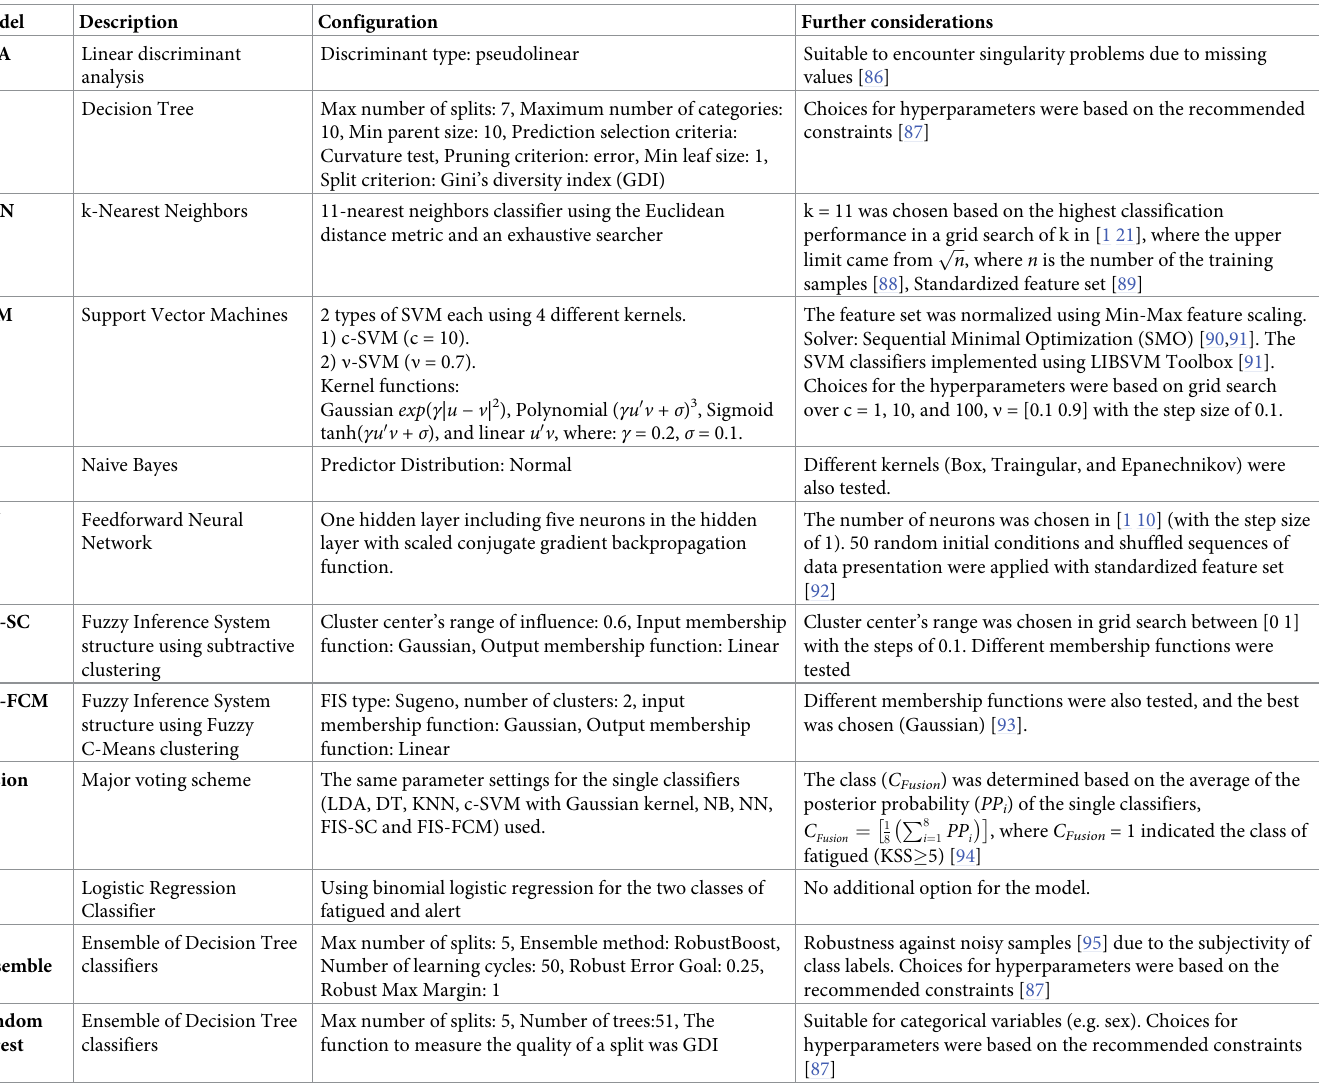
Table 2. The details of the classification